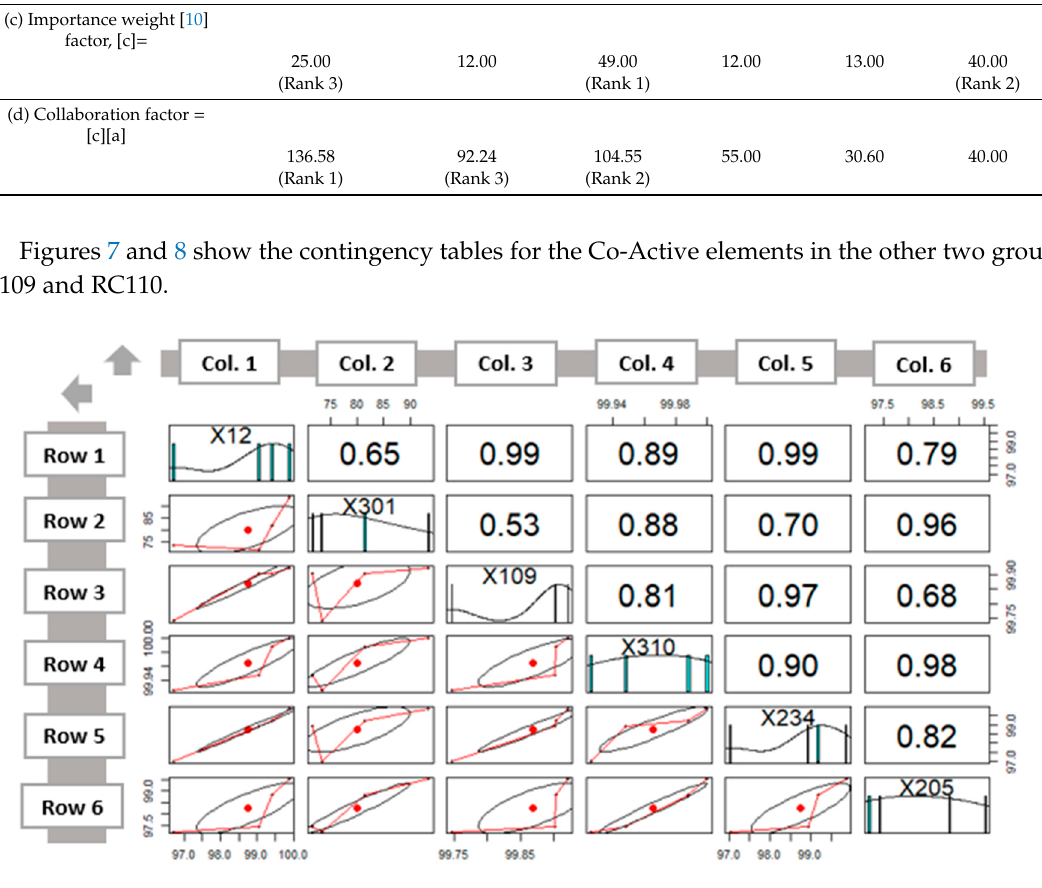
Figure 7. Contingency table for the Co-Active elements in the ‘PC109’ group.